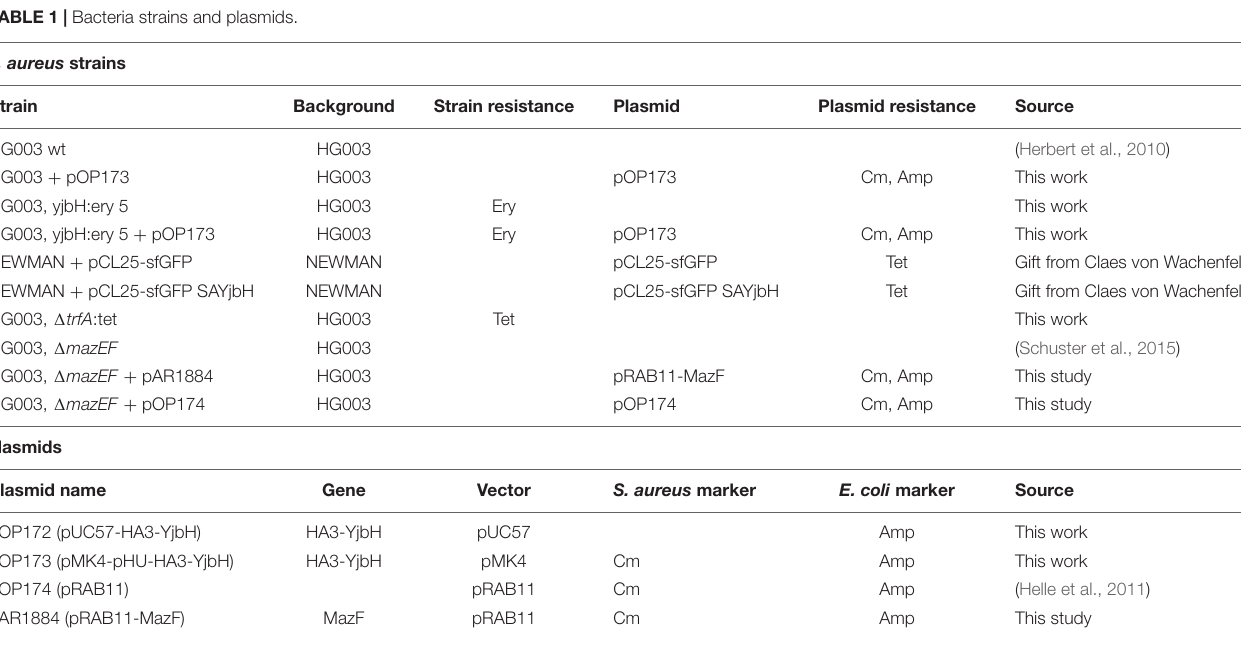
TABLE 1 | Bacteria strains and